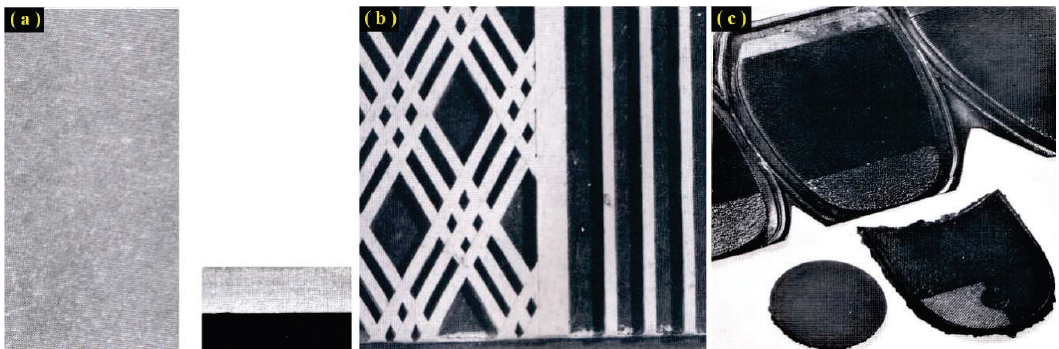
Figure 6. Products manufactured from RMPTD 10 formulation. ( a ) Laminate floor covering. The white surface is the top layer, the black band is the backing layer; ( b ) car floor mat; ( c ) soles and heels